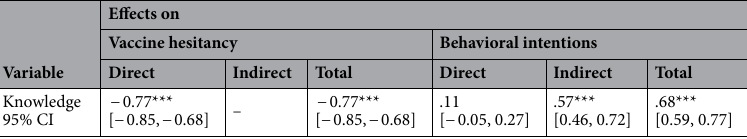
Table 2. Results of mediation analysis. *** p <